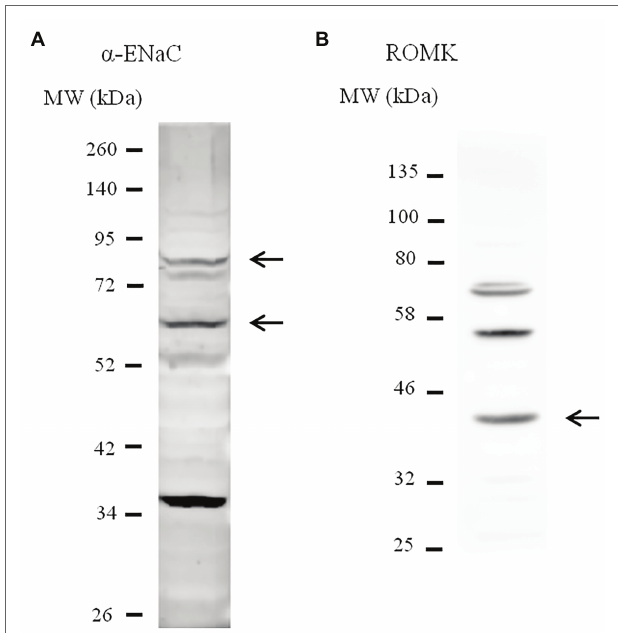
FIGURE 1 | Characterization of M-1 cell line by immunoblotting. Lysates from M-1 cells were immunoblotted with antibodies against anti- α -epithelial sodium channel (ENaC; A )and anti-renal outer medullary potassium (ROMK; B ) for cell line characterization. Arrows indicate the predicted bands that represent each protein, including full-length and the cleaved form of α